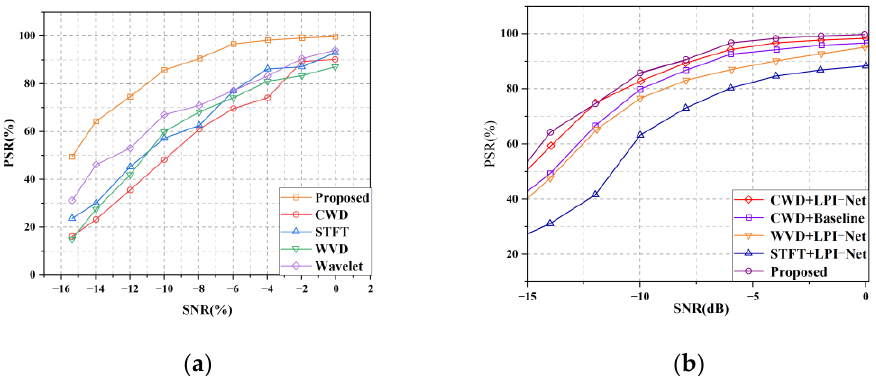
Figure 14. Recognition accuracy of different preprocessing methods in YOLOv5s: ( a ) the recognition accuracy of different preprocessing methods in YOLOv5s and ( b ) the comparison of recognition accuracy between the proposed multisignal recognition framework and LPI-NET and other frameworks.